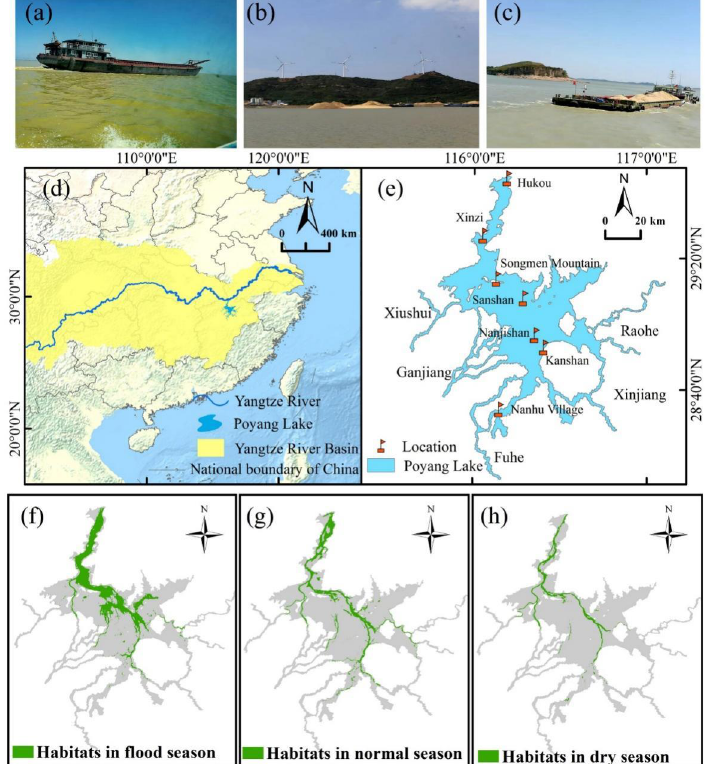
Figure 1. ( a – c ) Sand mining in Poyang Lake; ( d ) Yangtze River basin and location of Poyang Lake; ( e ) Tributaries of lake and locations marked; ( f – h ) Habitat configuration of the Yangtze finless porpoise in flood, normal and dry seasons [23].